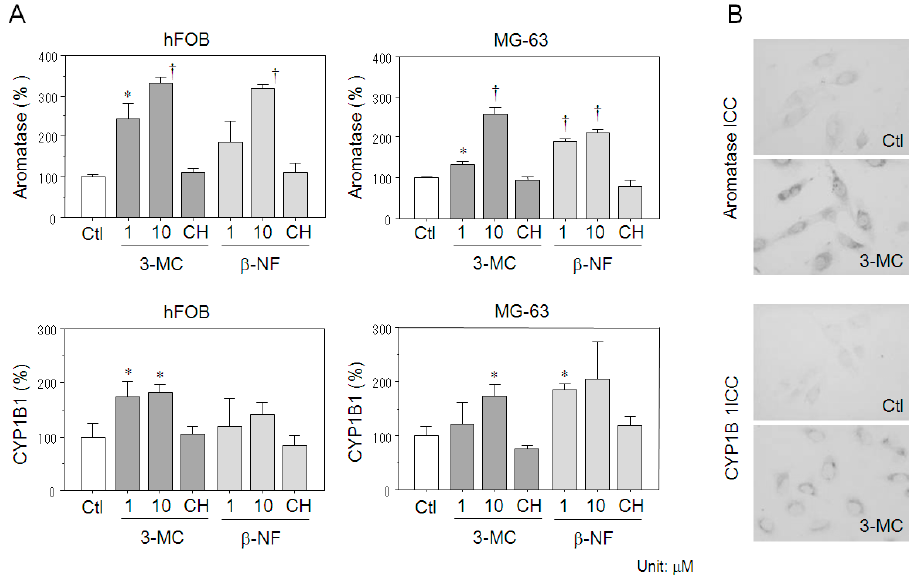
Figure 3. Induction of aromatase and CYP1B1 by AhR ligands in osteoblasts. ( A ) Both 3-methylcholanthrene (3-MC) and β -naphthoflavone ( β -NF) significantly increased aromatase expression in hFOB and MG-63 cells. There were no significant changes in aromatase expression in both hFOB and MG-63 cells co-treated with AhR agonist (3-MC or β -NF) and its antagonist (CH-223191) compared to vehicle control cells. * p < 0.05; † p < 0.01; Ctl, vehicle control (0.005% dimethyl sulfoxide); CH, 10 μ M CH-223191. ( B ) 3-MC markedly induced expression of both aromatase and CYP1B1 immunoreactivities compared with vehicle control in hFOB cells. ICC, immunocytochemistry; Ctl, vehicle control (0.005% dimethyl sulfoxide); 3-MC, 10 μ M 3-methylcholanthrene. Data are presented as mean and standard deviation ( n = 3).